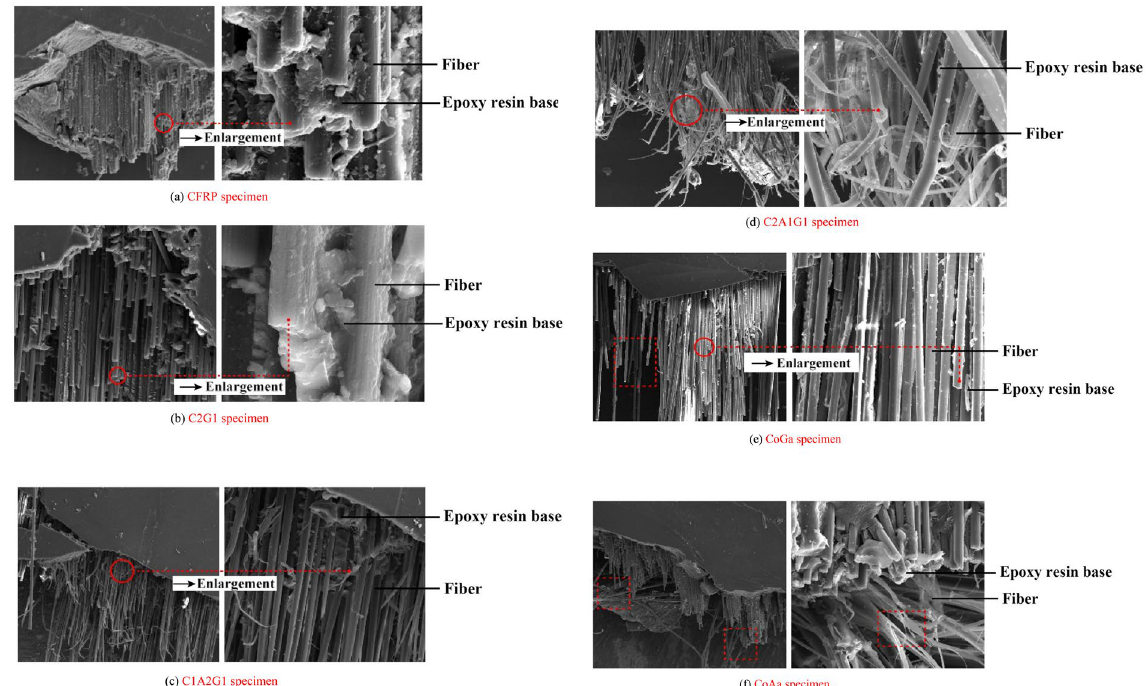
Fig. 4 Micromorphology of tensile fracture of HFRP specimens